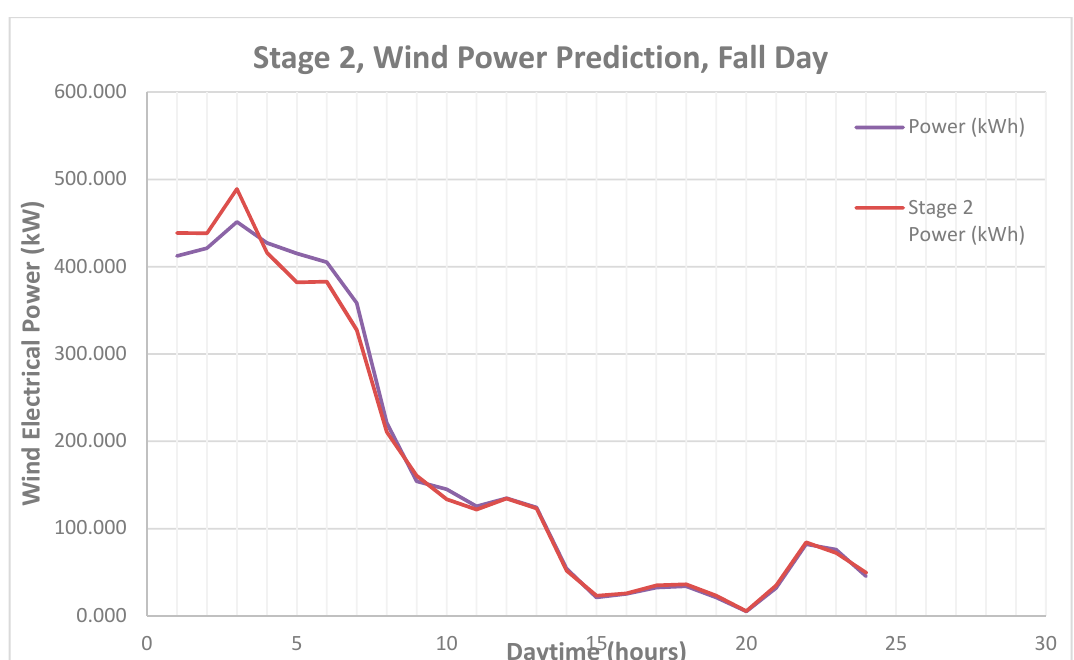
Figure 8. Wind Electrical Power forecasting results from Stage 2, Fall Day.